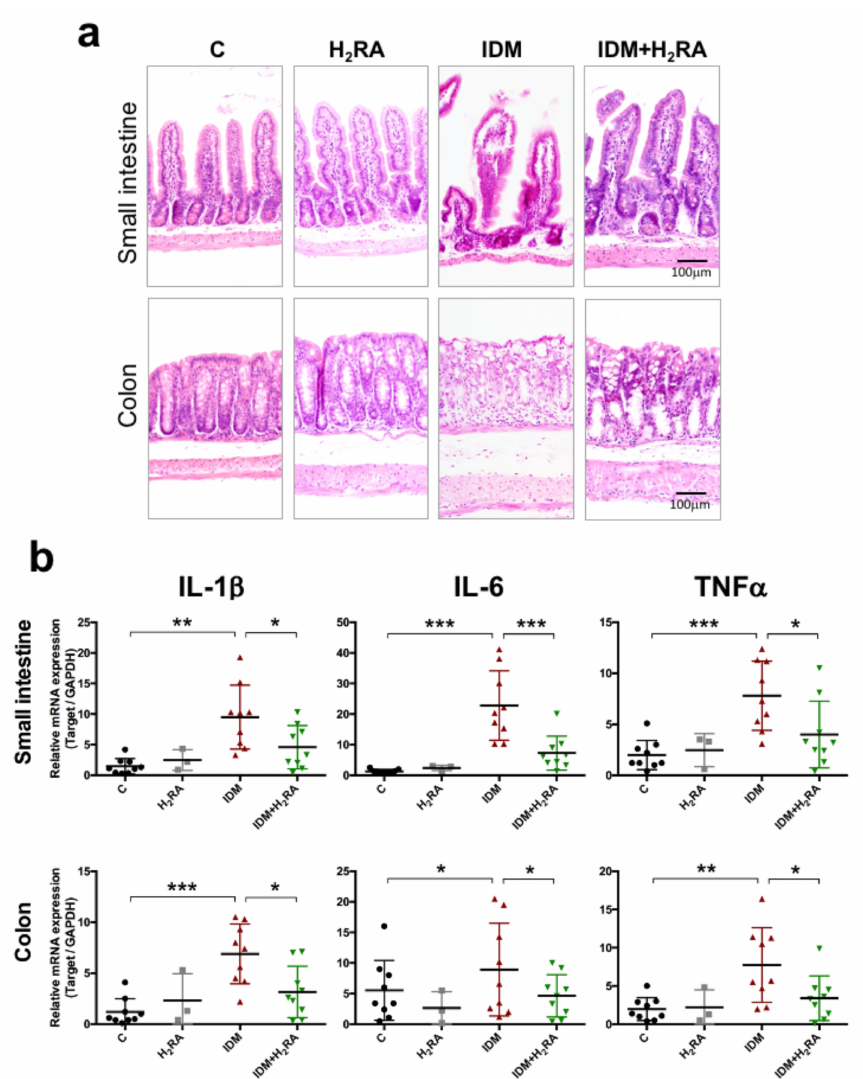
Figure 7. Morphological changes and e ff ects of the immunologic reaction in the intestinal mucosa of the Indometacin (IDM)-induced intestinal mucosal injury model with or without histamine H 2 -receptor antagonists (H 2 RA) administration. Two days post-IDM administration, histological observation using H & E staining ( a ) and analysis of mRNA expressions of the IL-1 β , IL-6, and TNF α ( b ) were performed using the intestinal tissue of 30 mice (9 control, 3 H 2 RA only, 9 IDM, and 9 IDM + H 2 RA mice). Statistical analysis was performed using a two-way ANOVA with Tukey’s post-hoc test. * p < 0.05, ** p < 0.01, *** p <